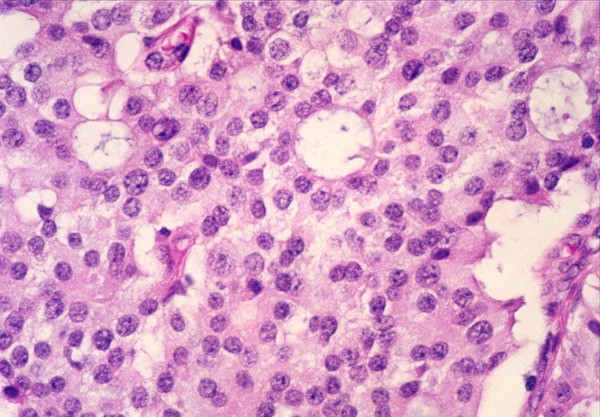
The pathologic findings were of a well-encapsulated solid mass containing cells with a diffuse, trabecular growth pattern. (×40, H&E).